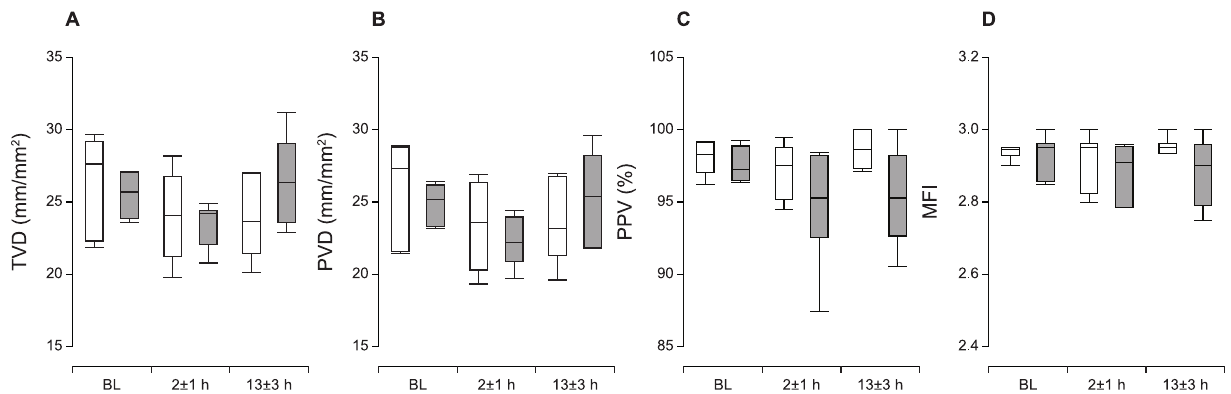
Figure 3. Total and Perfused Small Vessel Densities. A–B: The total small vessel density (TVD) and perfused small vessel density (PVD) were fully preserved after coronary microembolization (CME). C: The proportion of perfused small vessels (PPV) was also identical across time points and between groups. D: The microvascular flow index (MFI) was not affected by CME. The data are presented as median 6 range. Open box plots, time- matched control group; filled box plots, cardiogenic shock group.